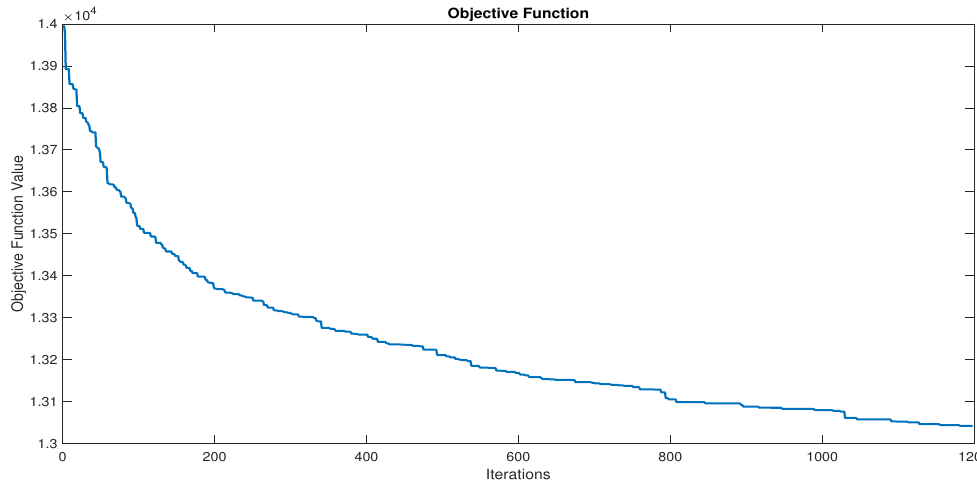
Figure 5. Objective function behaviour of the optimum solution for Region